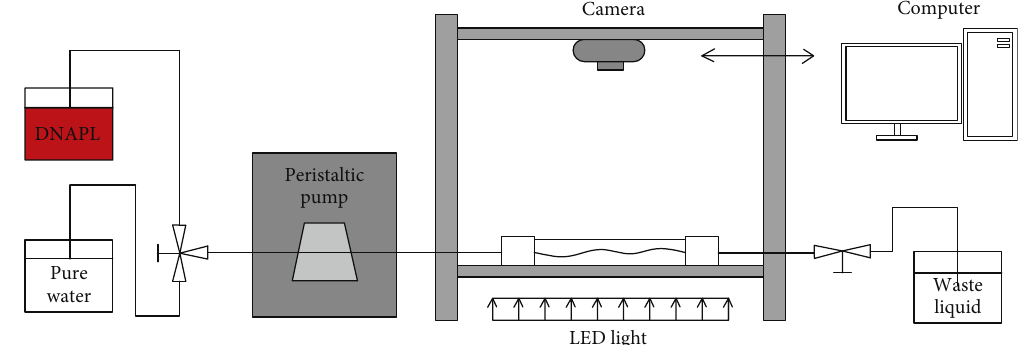
Figure 3: Schematic diagram of experimental apparatus.